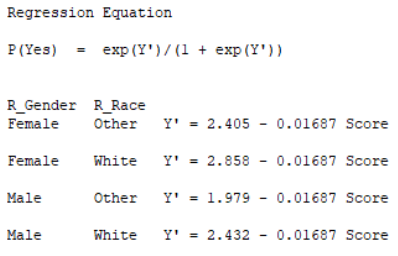
Figure 9. Adjusted logistic regression model.